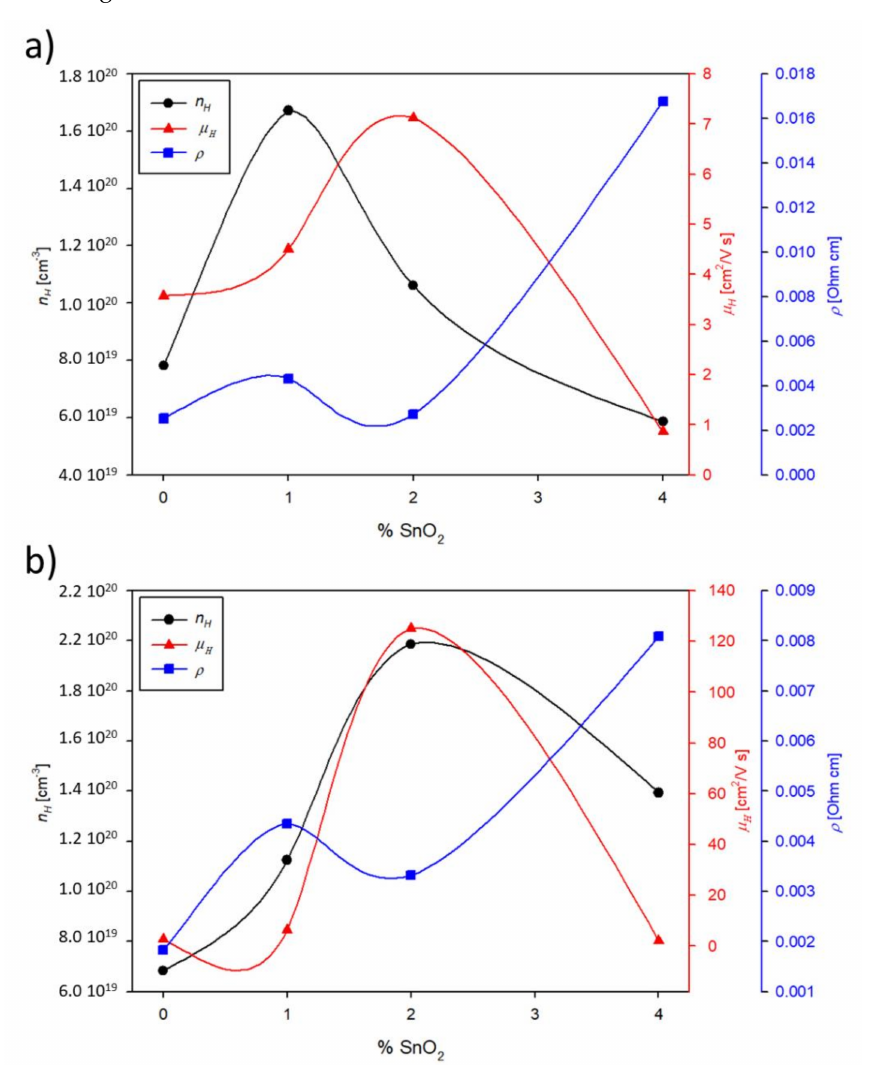
Figure 5. Hall effect measurements of the number of carriers and their mobility for films deposited ( a ) on silica (series AZO_xS) and ( b ) Al 2 O 3 (series AZO_xA) plotted versus the % content of SnO 2